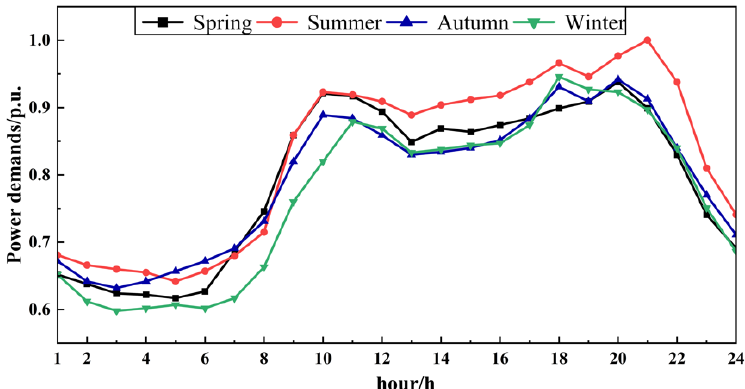
Figure 5. Wind maximum of four-season typical days.